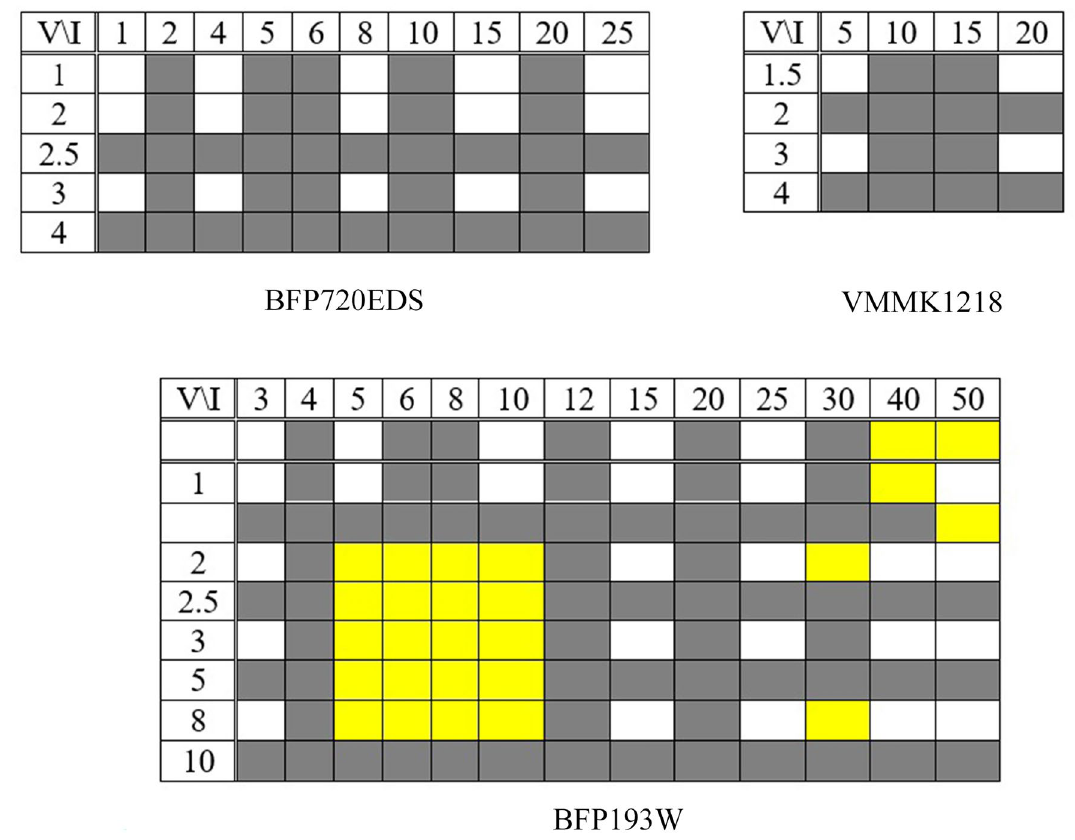
Figure 4. The assignment of training (while boxes) and testing samples (grey boxes) in terms of the bias conditions (V/I). The yellow boxes represent those combinations of bias conditions for which measurement data was not